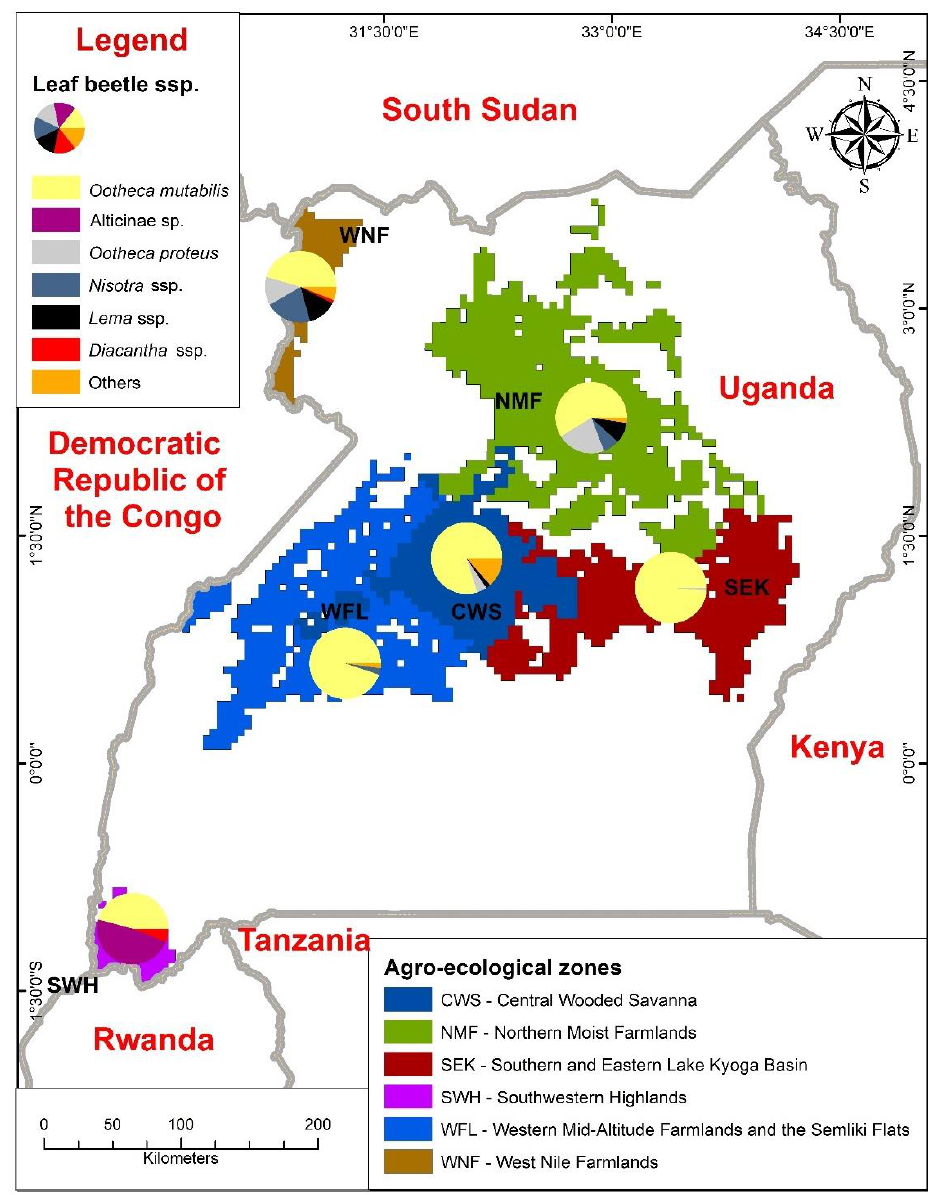
Figure 3. Composition of bean leaf beetles in different agro-ecological zones in Uganda. In all agro-ecological zones, results from host plant density (Table S6), time of sampling (Table S7), cropping history (Table S8), and insecticide usage history (Table S9) for both bean leaf beetle density and foliar damage were not significant ( p >